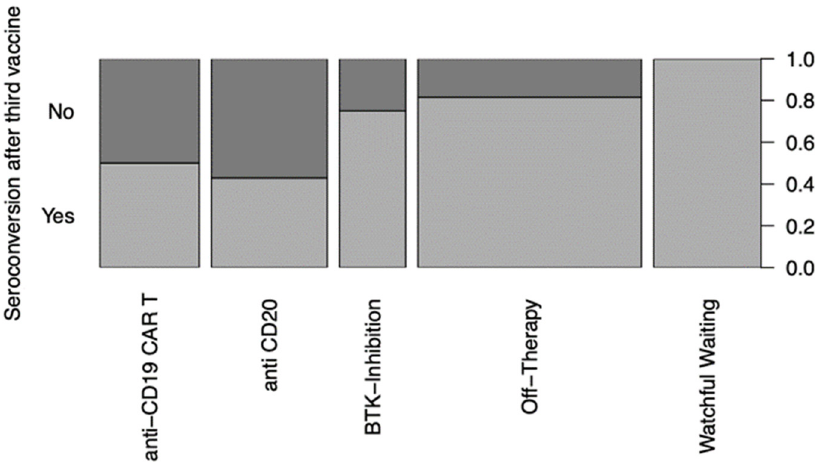
Figure 3. Mosaic plot of seroconversion with a >0.8 BAU/mL after the 3rd vaccination distributed by treatment modality. Anti-CD19 CAR T ( n = 12), anti-CD20 treatment ( n = 14), BTKi ( n = 8), “off-therapy” ( n = 27) and “watchful waiting” ( n = 13).